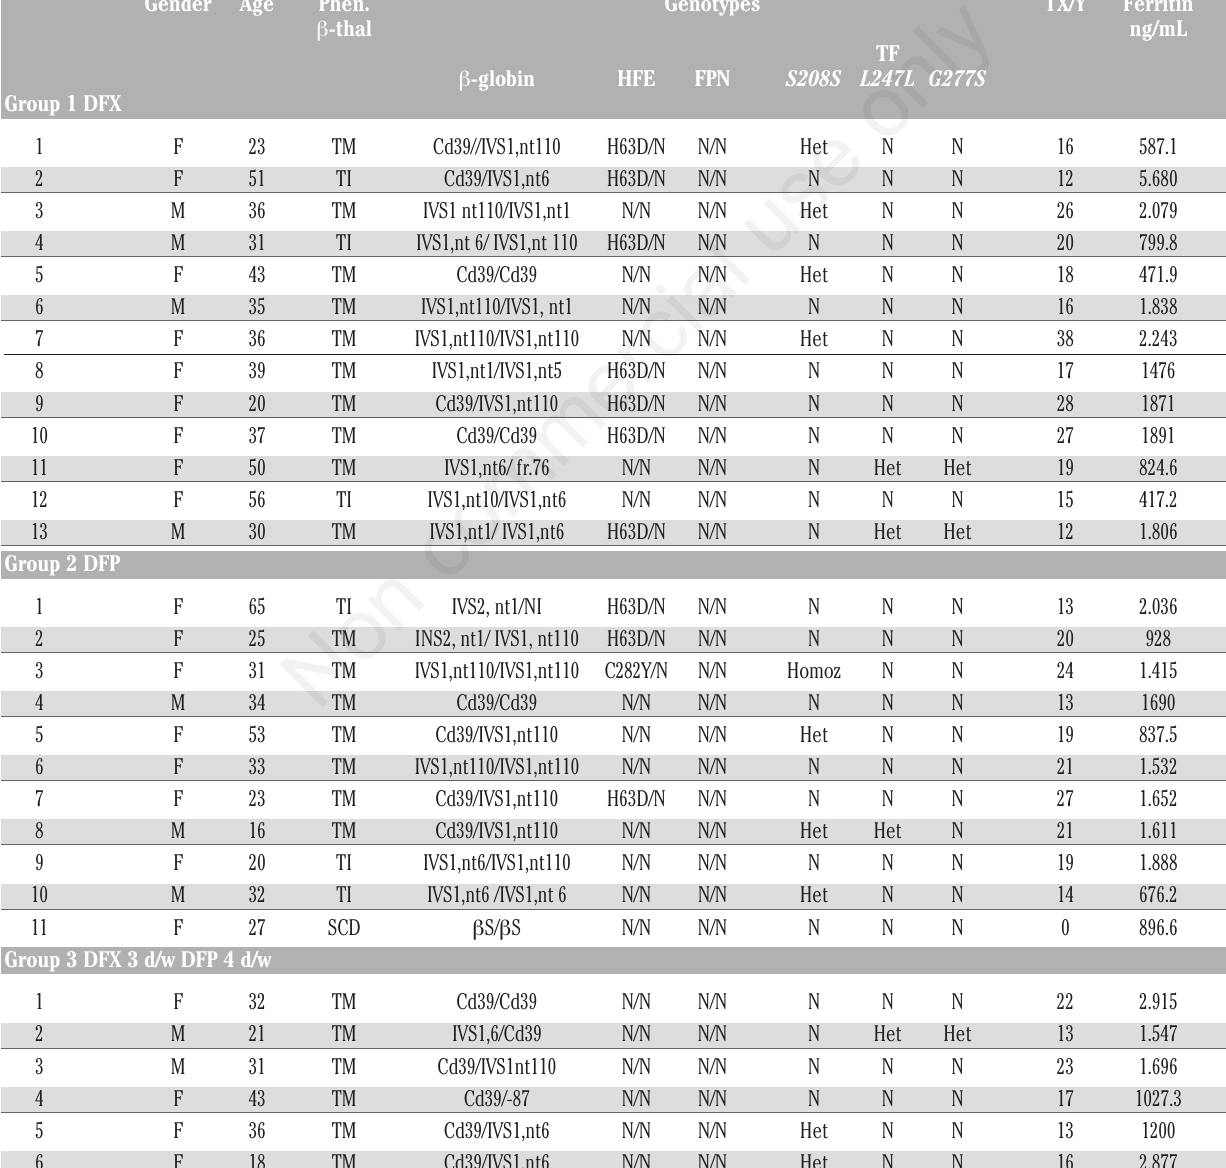
Table 2. Patients’ genotypes and phenotypes related to transfusional and chelating therapy.